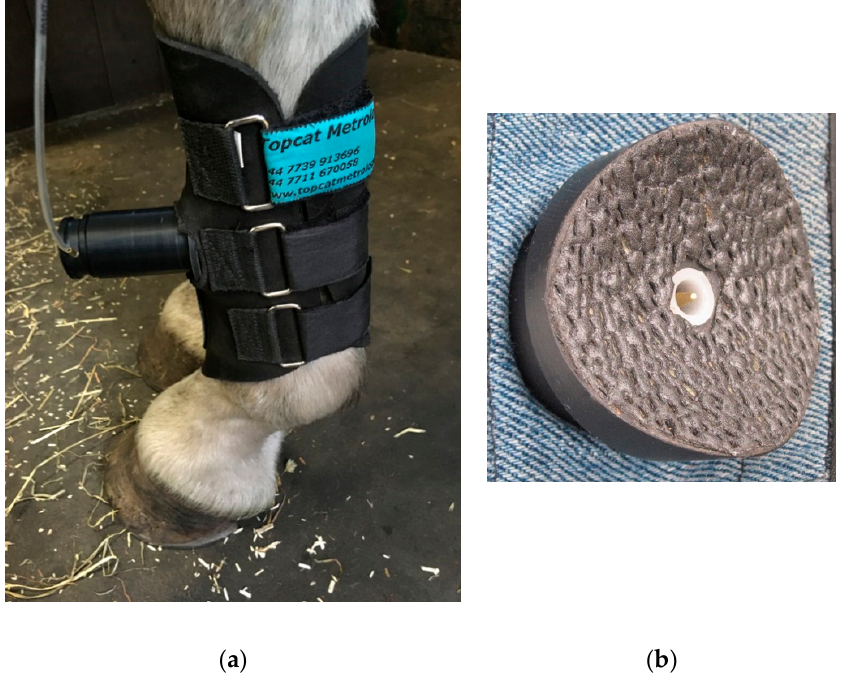
Figure 7. Pneumatic actuator: ( a ) secured with boot and carefully tensioned band on the forelimb of a horse standing free in its stall, ( b ) the leg side of the actuator showing probe tip in resting position.